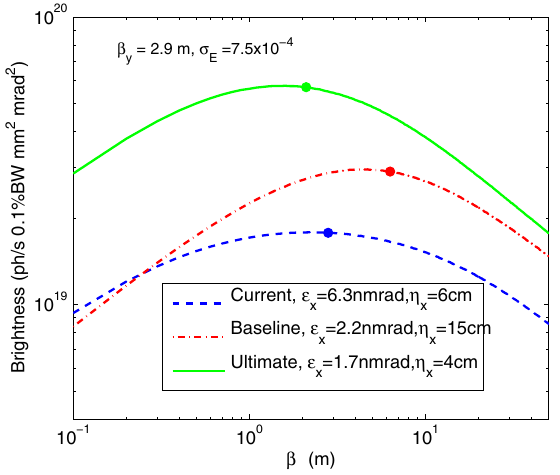
FIG. 2. Undulator brightness as functions of the (cid:4) x for three different type lattices. The numerical synchrotron radiation code SDDSBRIGHTNESS / URGENT is used for the calculation. The bright- ness is calculated at a photon wavelength of 3 nm for an undulator with the period length of 50 mm, and total length of 4.45 m. The dots represent the locations of optimal beta calcu- lated using Eq.